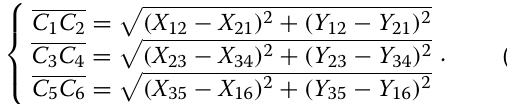
tangent points C 1 , C 2 , C 3 , C 4 , C 5 and C 6 in fixed coordinate system